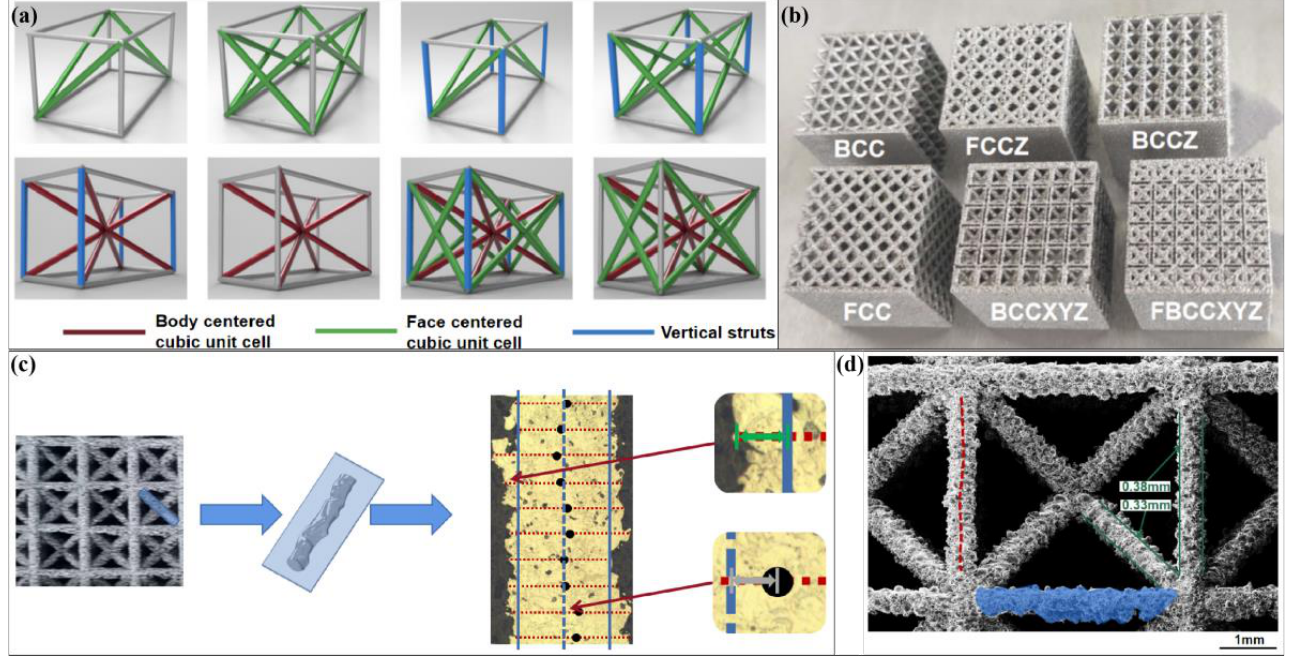
Figure 9. As-printed micro-rod-lattices: ( a ) geometric configurations; ( b ) macroscopic morphology after L-PBF 3D printing; ( c ) SEM and cross-sectional morphology of a typical micro-rod in the BCC lattice structure; ( d ) SEM morphology of an as-printed BCC lattice.